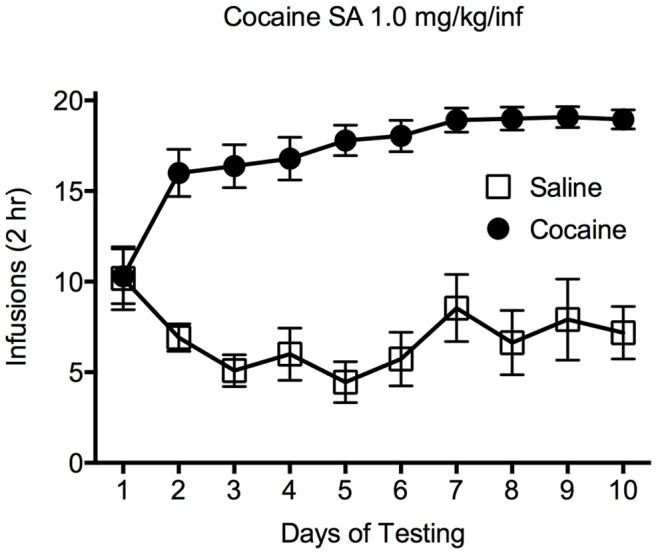
Self-administration of cocaine or saline.This plot shows the number of infusions earned across ten days of self-administration of cocaine (1.0 mg/kg/inf) or saline. Closed circles represent animals self-administering cocaine, open squares indicate animals receiving infusions of saline. Data are expressed as the average number of infusions (± SEM) over the ten days of cocaine/saline self-administration; *p<0.05.